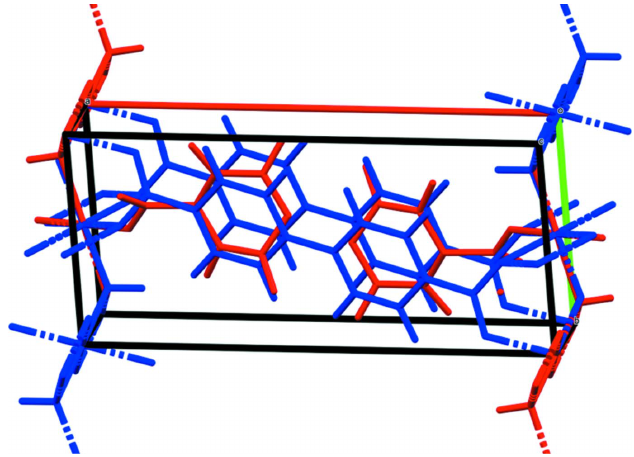
Figure 5 Comparison of the Rietveld-refined (red) and VASP -optimized (blue) structures of Co 2 (BPDC)(OH) 2 . The r.m.s. Cartesian displacement is 0.264 A˚ . Image generated using Mercury (Macrae et al. ,